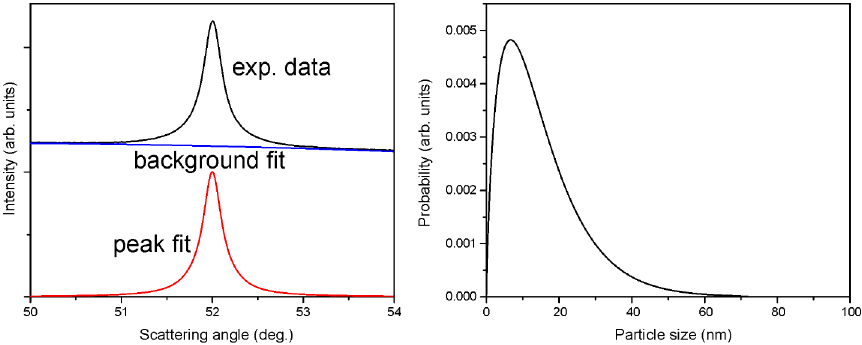
Figure 6. XRD results for the SCD sample. ( Left ): 400 diffraction line shape and its fit. The noise level is comparable to the line thickness. ( Right ): Evaluated ND size distribution function [40].